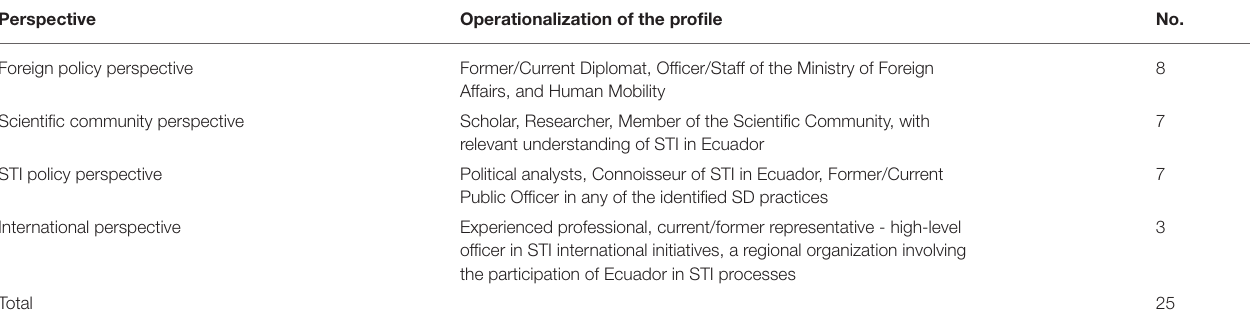
TABLE 1 | Perspectives—balanced interviewees viewpoints and sector of action and experience.